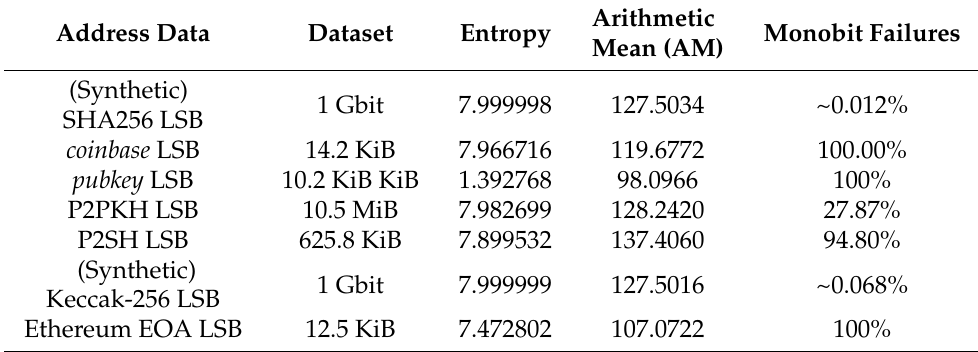
Table 4. Results of the statistical analysis of the chunk number